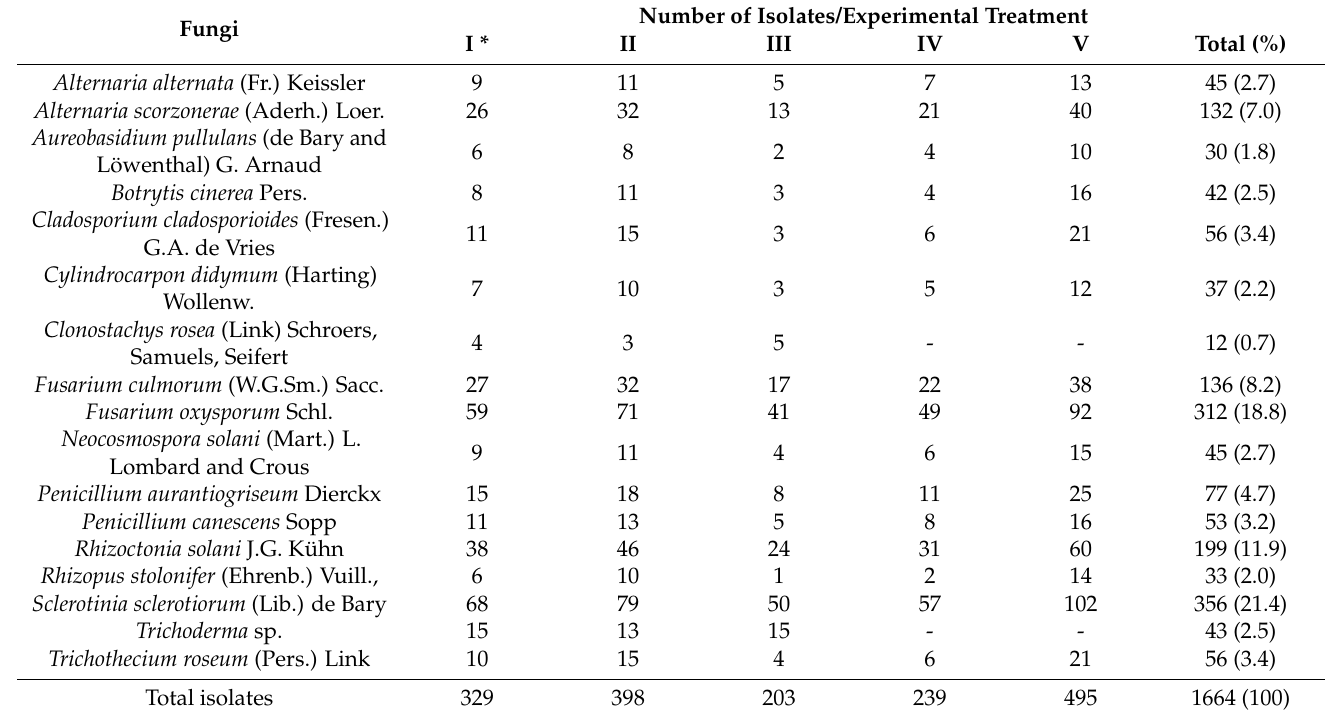
Table 3. Fungi isolated from diseased scorzonera roots after harvest (sum 2014–2016).